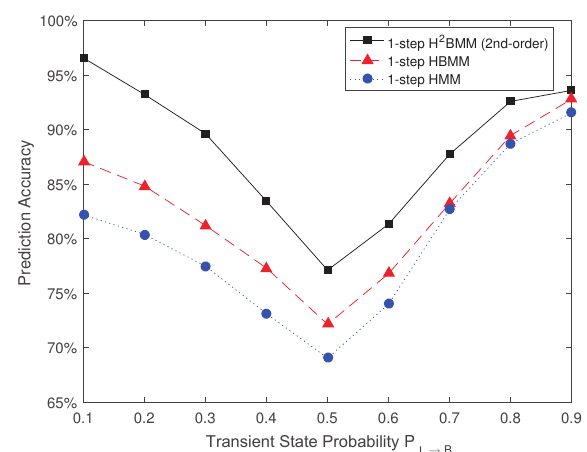
Figure 5. Prediction accuracy of H 2 BMM, HBMM and HMM when P , P from 0.1 to 0.9 B → I = 0 . 8 I → B